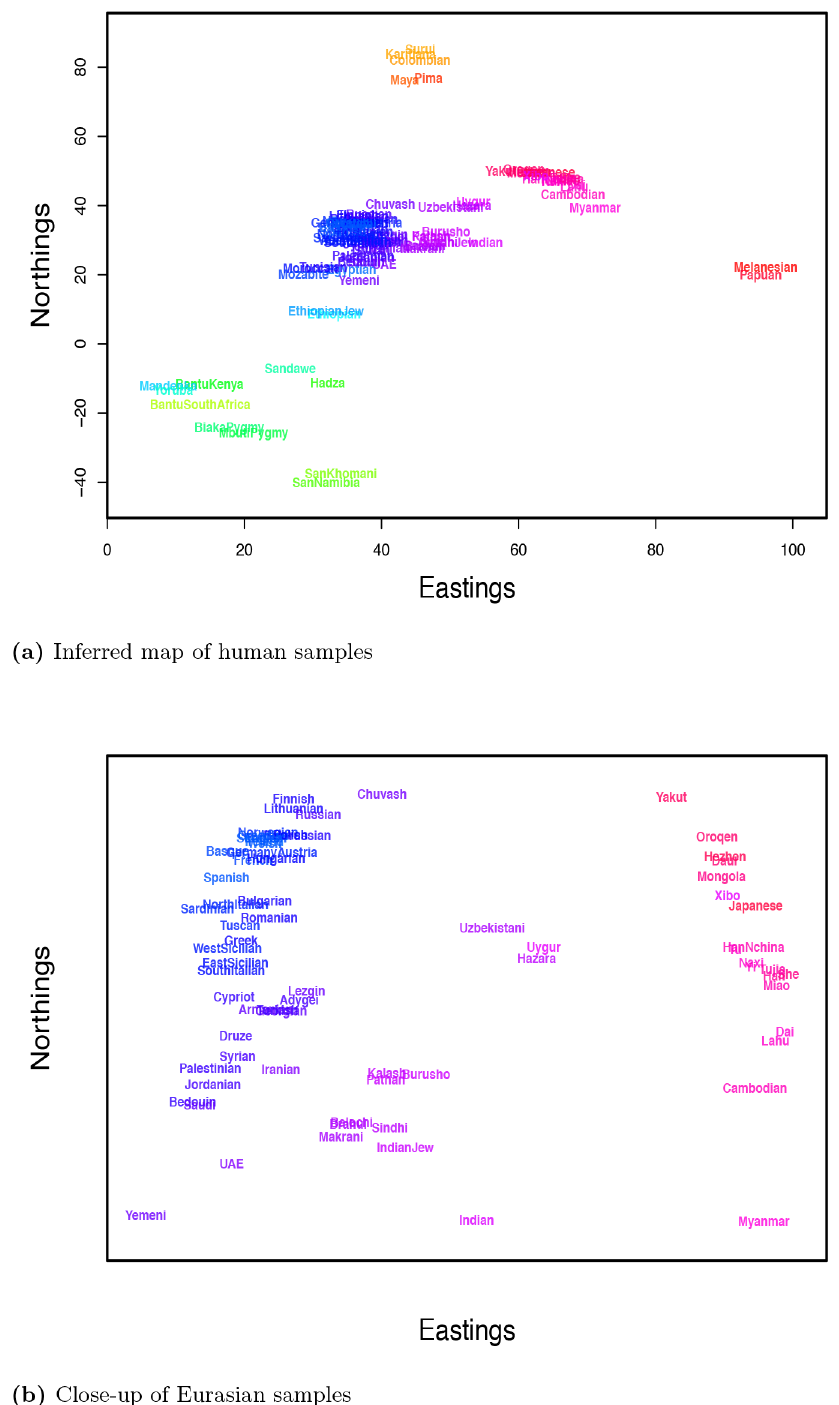
Fig 8. Geogenetic map of human samples, inferred without admixture. a) complete map; b) close-up of Eurasian samples.